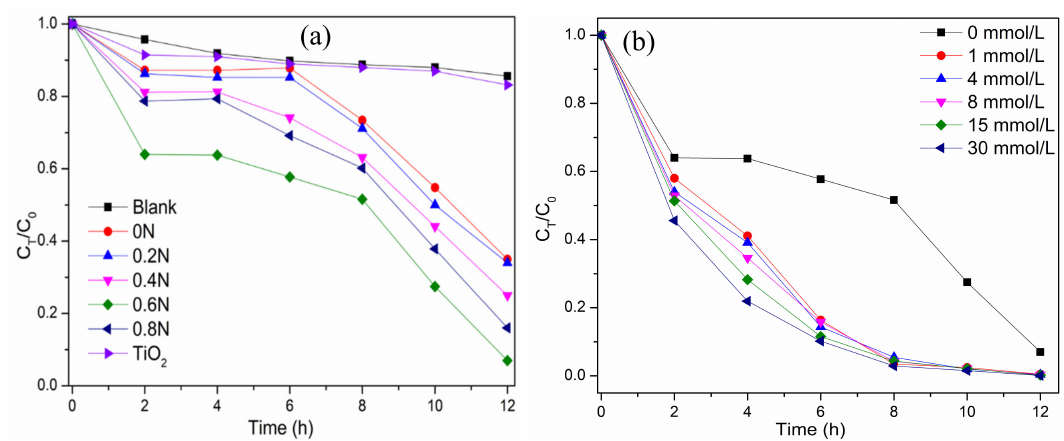
Figure 5. ( a ) The degradation curves of chlorophyll-a in algae cells on di ff erent TiO 2 samples under visible light irradiation; ( b ) E ff ect of H 2 O 2 concentrations on the degradation of chlorophyll-a in algae cells over 0.6